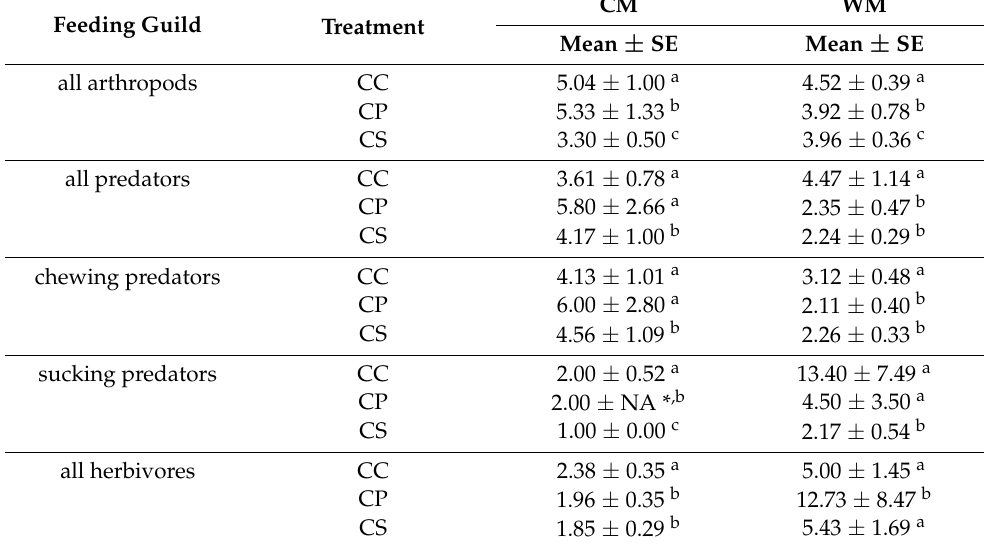
Table 3. Mean abundances of all arthropods and their main feeding guilds captured in the pitfall trap samples in soybean in 2018 at two field sites, Beltsville [Central Maryland (CM)] and Keedysville [Western Maryland (WM)], across three post-harvest treatments following corn harvest. For the three treatments, CC denotes cover crop planted in corn residue/stubble; CP represents chisel plowed (conventional tillage) plots; and CS (corn stubble) no action. Mean values and standard errors (Mean ± SE) and results of statistical comparisons via fitted GLMMs are